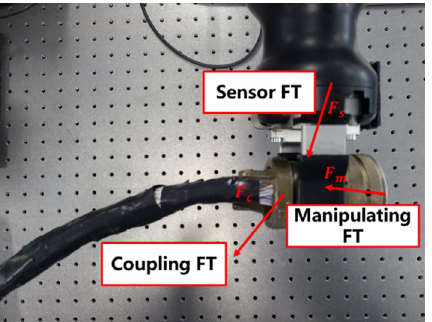
Figure 1. The task of robotic aeronautic cable insertion